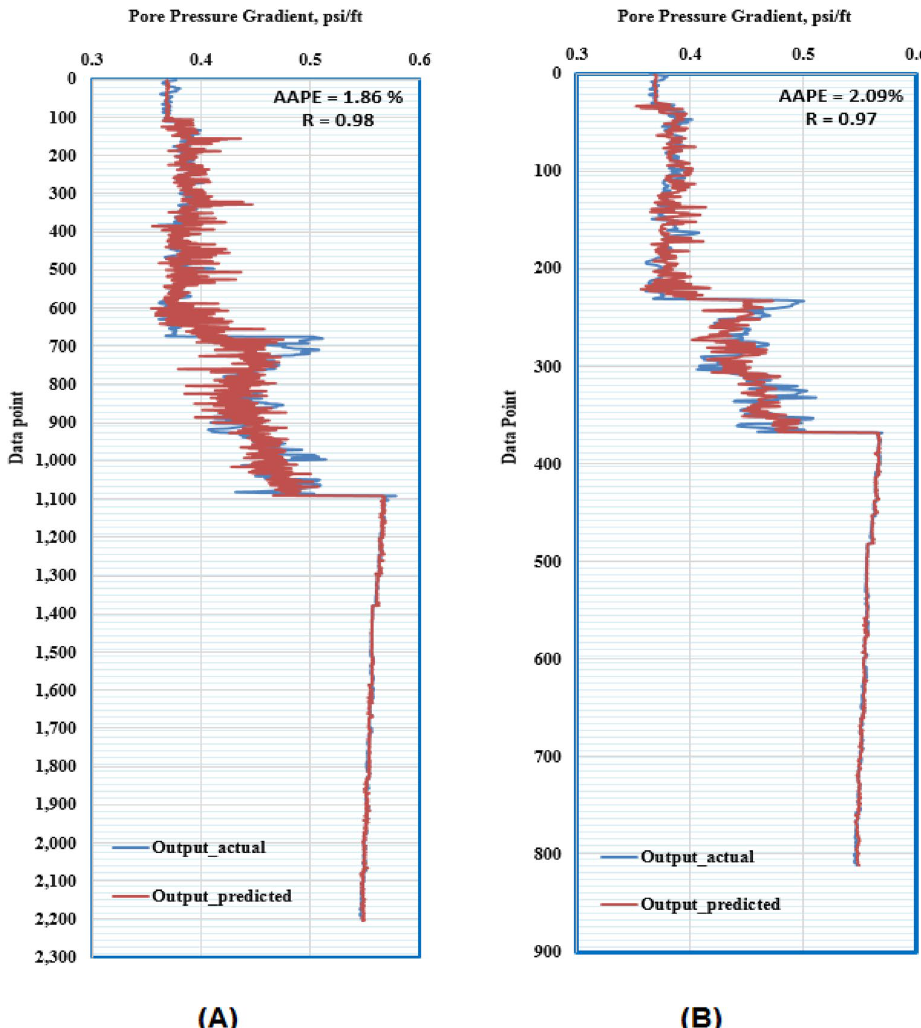
Figure 10. Formation pressure gradient profiles ( A ) training, and ( B ) testing (ANFIS model).